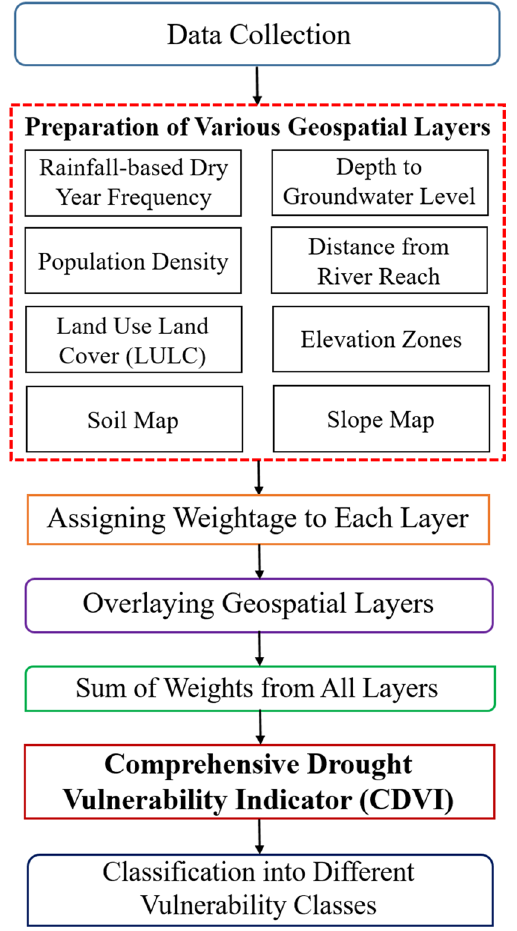
Fig. 2 The methodology adopted for comprehensive drought vulner- ability